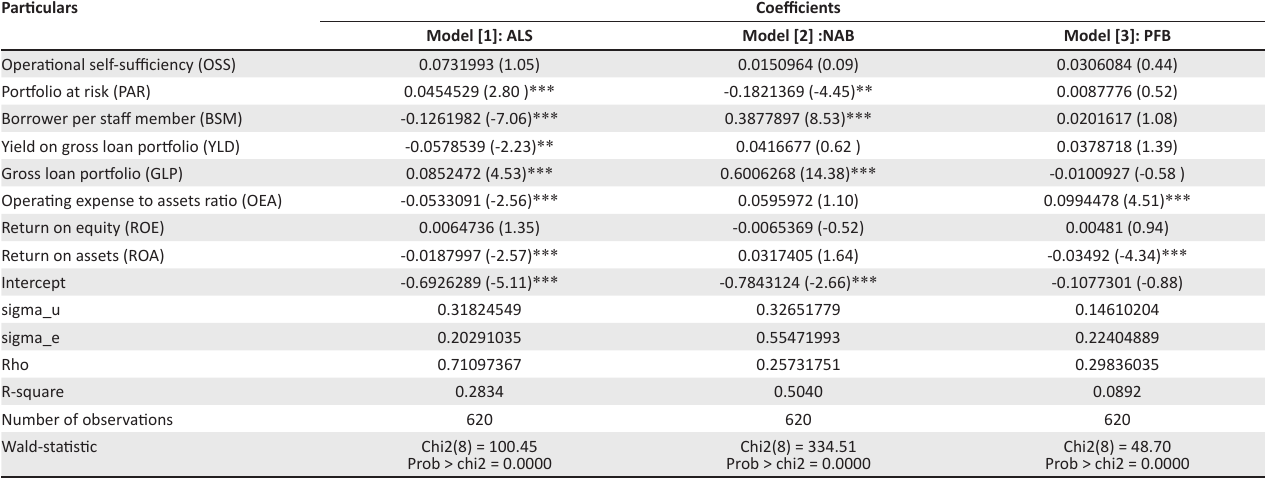
TABLE 4: Random effects results of the determinants of outreach (Dependent: ALS, NAB, PFB).